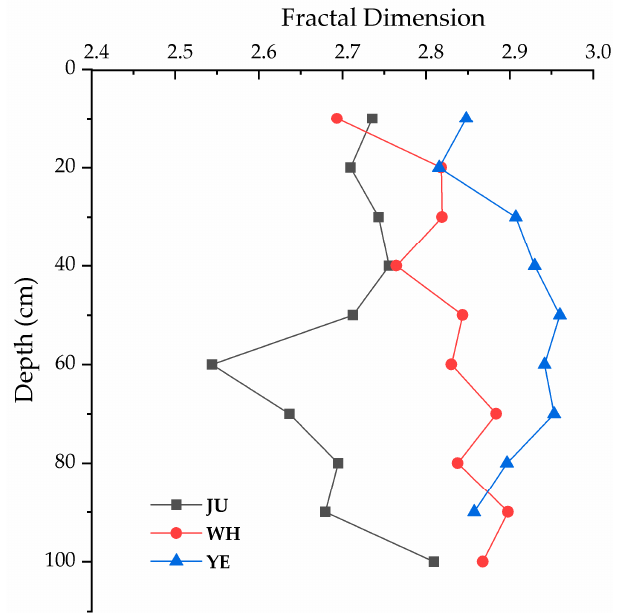
Figure 8. Fractal dimension ( D ) of WSA in the JU, WH, and YE profiles.